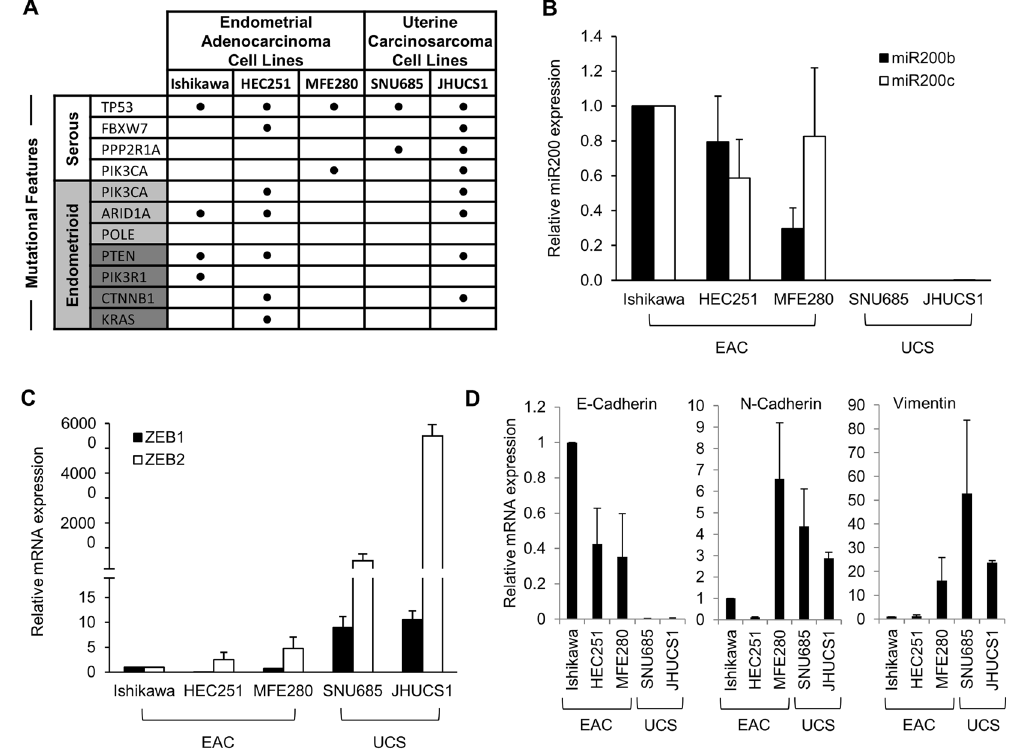
Figure 1. Mutational and gene expression characteristics of EAC and UCS cell lines. ( A ) Mutational landscape of EAC and UCS cell lines. Mutational features (first column) are classified according to endometrial carcinoma histologic subtype: serous (white) or endometrioid (gray). Mutations depicted in dark gray are rarely found in serous carcinomas, while mutations depicted in light gray are more common in endometrioid carcinomas but may also be present in serous carcinomas. ( B ) Relative miR-200, ( C ) ZEB1 and ZEB2, and ( D ) E-cadherin, N-cadherin and vimentin gene expression in EAC and UCS cell lines. Data are normalized to Ishikawa cell line. Data are reported as mean ±